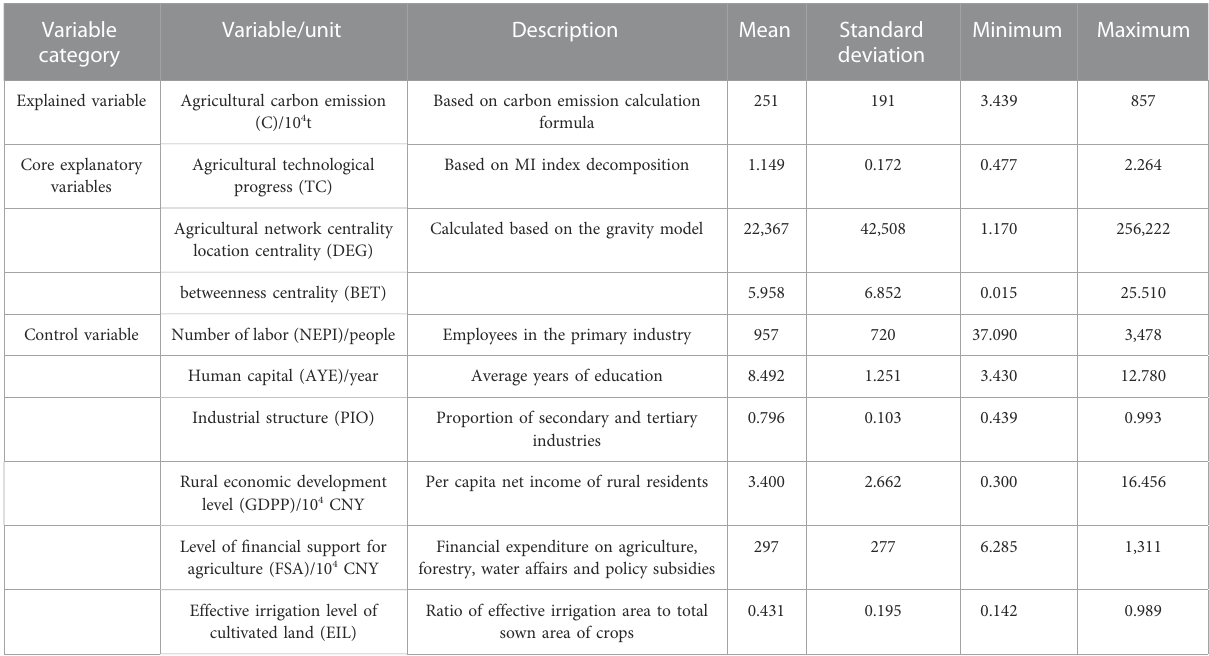
TABLE 2 Variable de fi nitions and descriptive